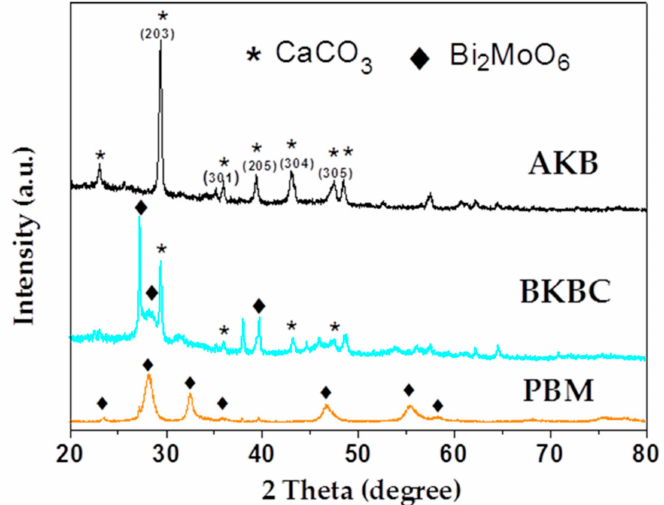
Figure 3. XRD patterns of AKB, BKBC, and PBM.